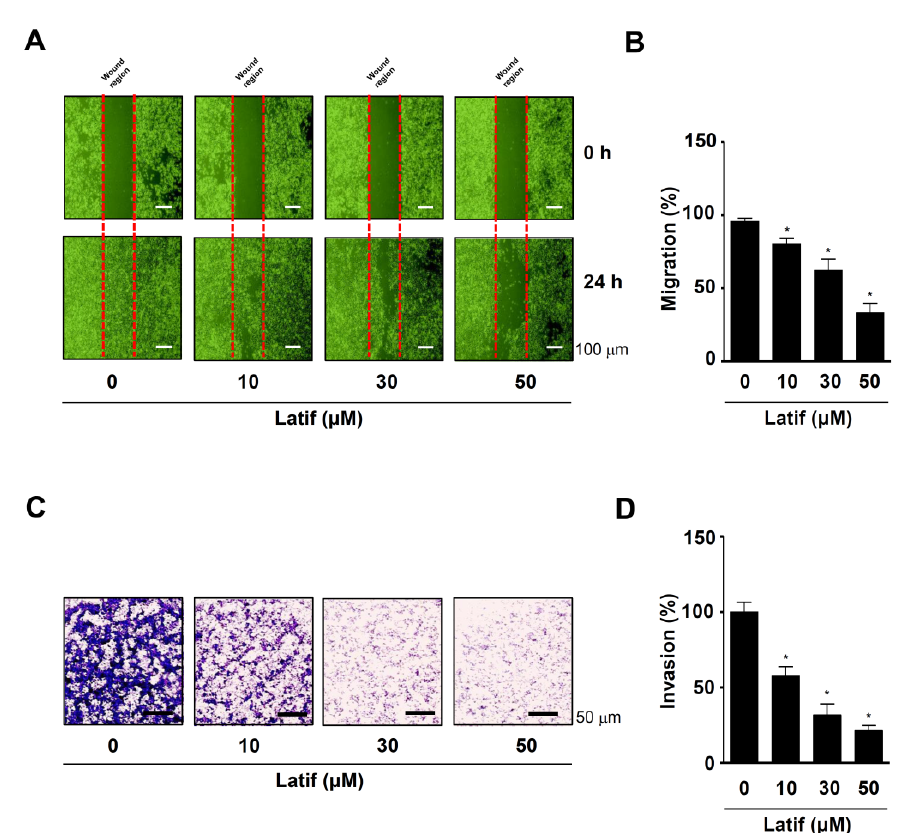
Figure 6. Effects of Latif on cell migration and invasion in human YD-10B OSCCs. ( A , B ) Amounts of 10, 30, and 50 μ M Latif were treated for 24 h in YD-10B OSCCs, and then cell migration was then analyzed using a wound-healing assay. At the indicated time points, the migration rates were monitored using a light microscope ( A ). The bar graph shows the relative value of migration (%) normalized to the control ( B ). ( C , D ) The invasion rates of Latif-treated cells (10, 30, and 50 μ M) were analyzed using a Boyden chamber assay. Invasive cells were fixed, stained, and observed using a light microscope ( C ). The bar graph shows the relative value of invasion (%) normalized to the control ( D ). Data are represented as mean ± S.E.M. Significance was set at p < 0.05, which is indicated by an asterisk in the graph.